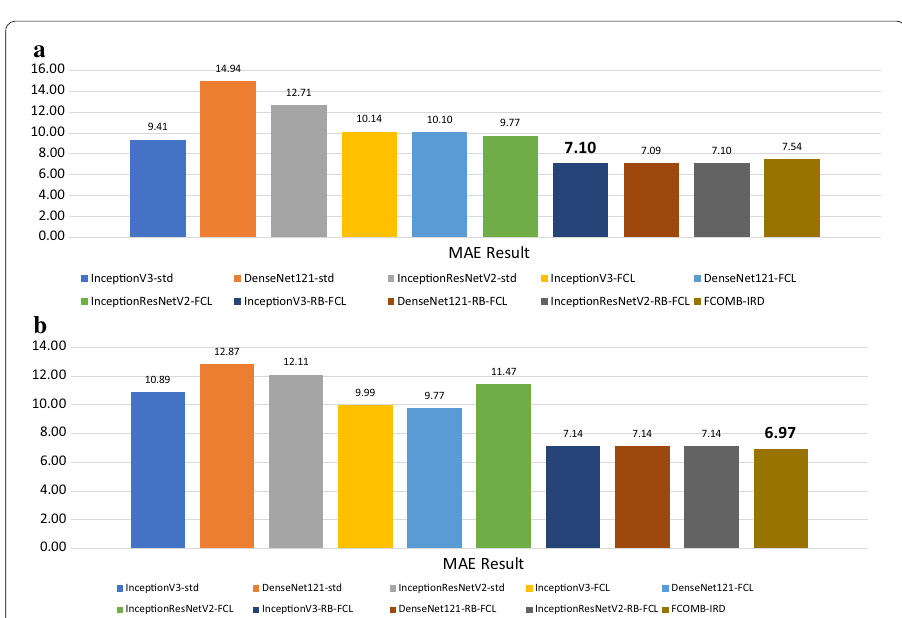
Fig. 3 Summary of scenarios comparison (MAE), a Digital hand atlas dataset and b RSNA